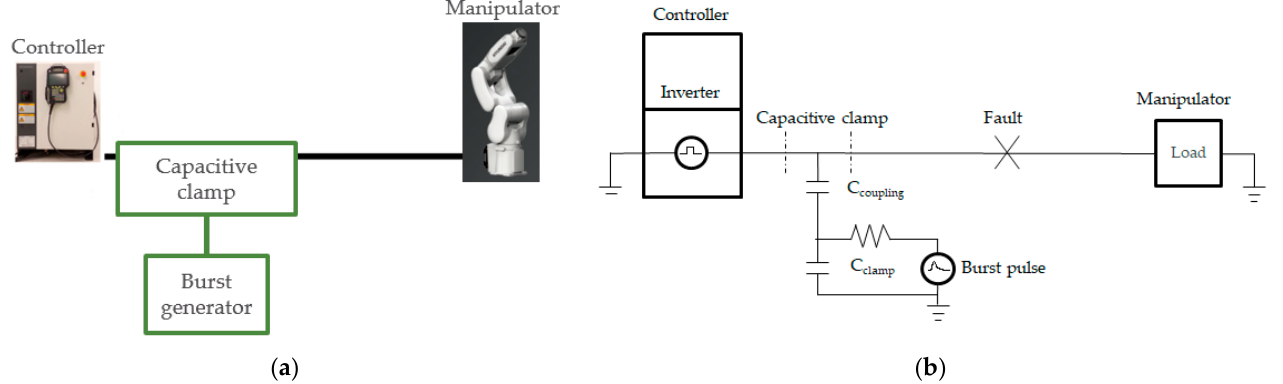
Figure 6. ( a ) Nonintrusive periodic burst signal injection method. ( b ) Equivalent circuit.